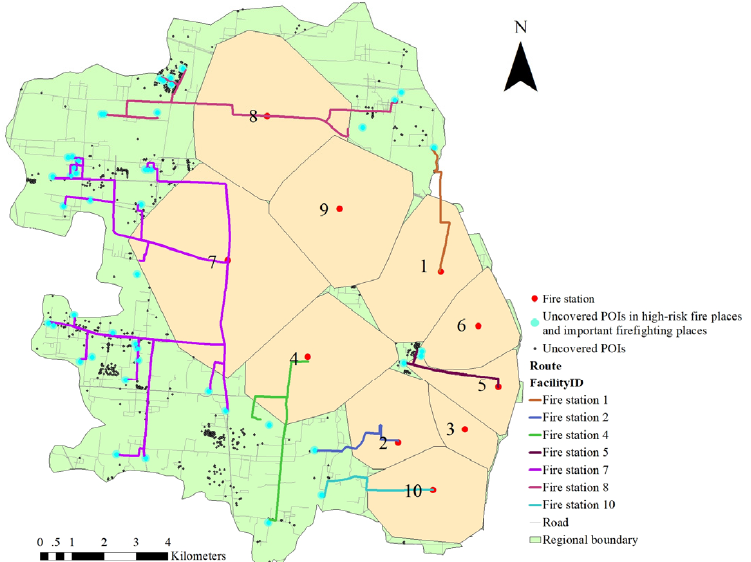
Figure 9. Uncovered POI points of high-fire risk places and important firefighting places.